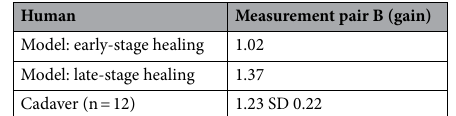
Table 3. Human results of Injectrode-augmented EBGS.